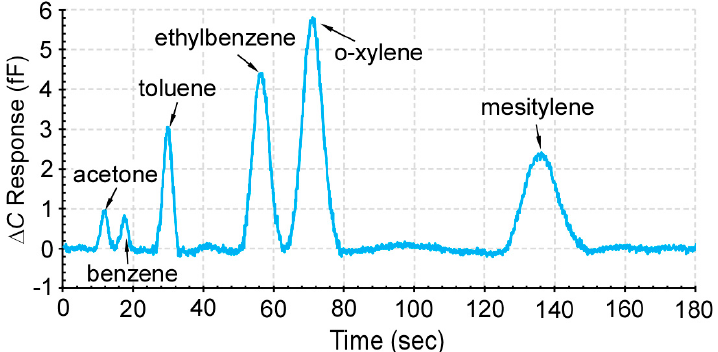
Figure 13. A typical chromatogram provided by the gas chromatography system, which was supported by the 3D-KP.MCE. Six different chemicals were successfully collected, separated, and detected.